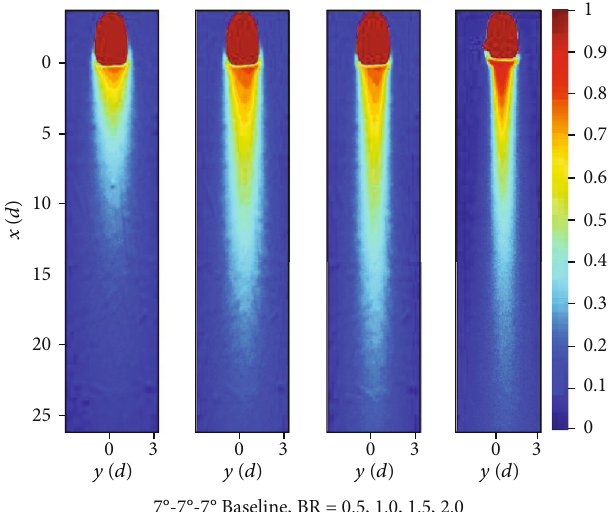
Figure 7: Film cooling e ff ectiveness distributions downstream of the baseline geometry.